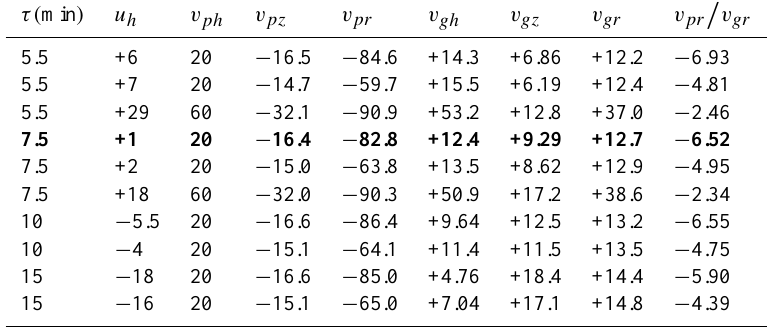
Table 2. Charateristic propagation velocities of gravity waves calculated from the dispersion relation with τ b = 5.0min, H = 8km, v ph = 20 ∼ 60m/s and downward vertical phase propagation. The radar beam direction is defined by θ = 50 ◦ and φ = 45 ◦ . All the veloci- ties are in m/s, wave periods in min. The case in the 4th row corresponds to the numerical wave packet of Fig. 2. τ( min ) u h v ph v pz v pr v gh v gz v gr